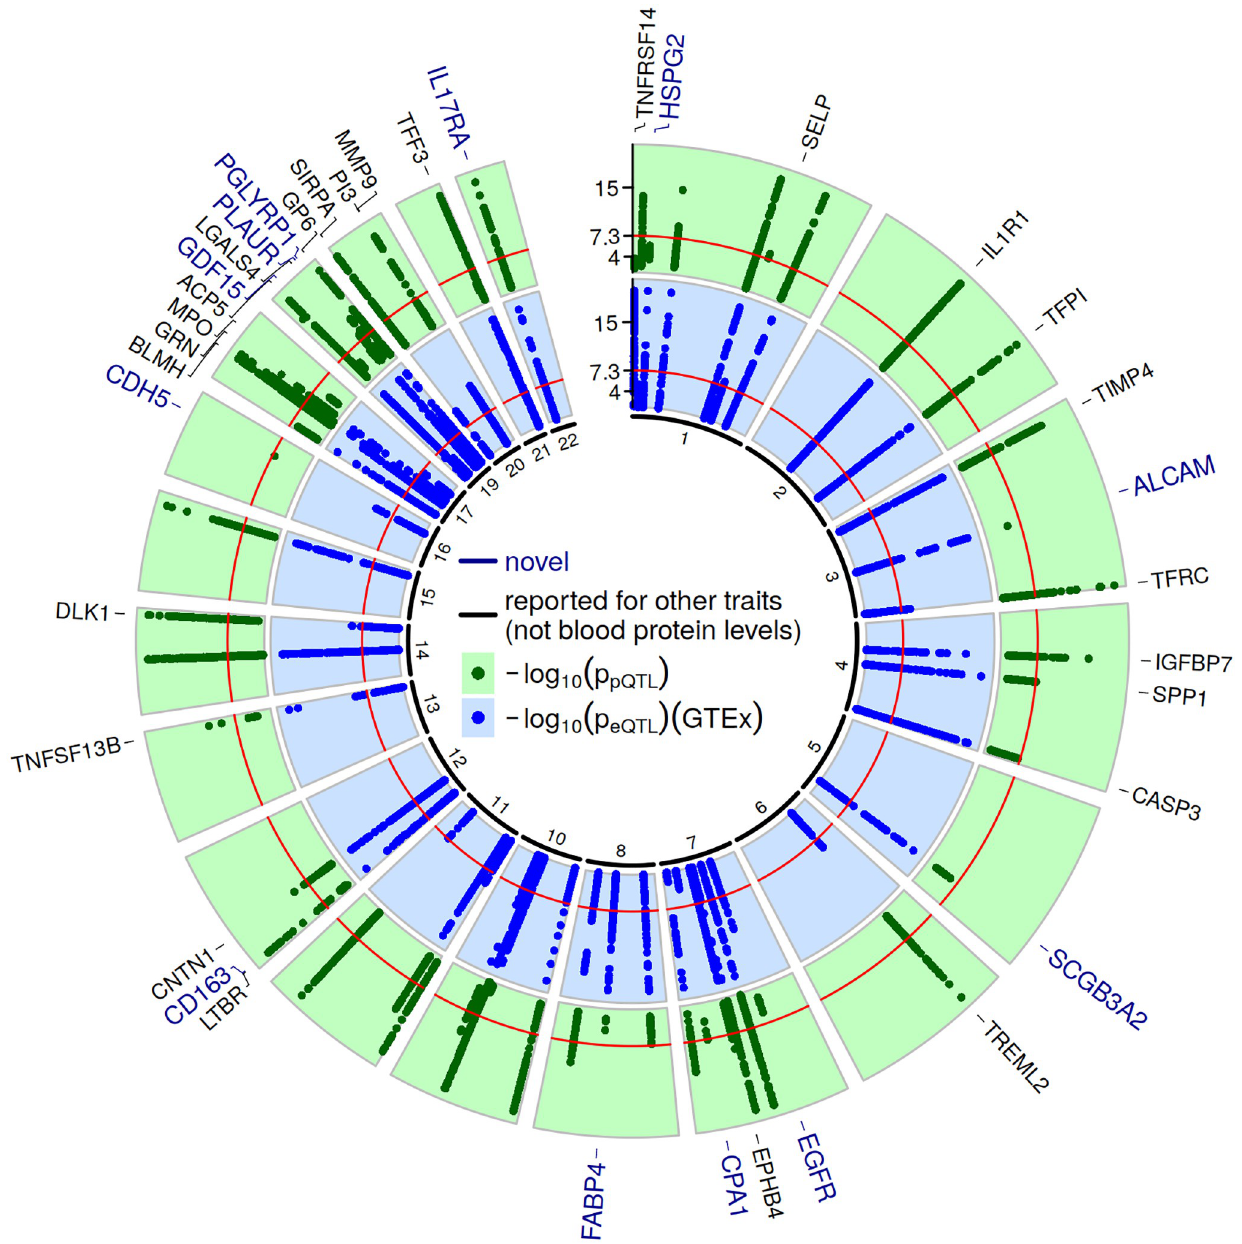
Fig 1. Circular plot of cis-associations. Log-transformed p-values for cis-pQTLs and eQTLs are shown in the green respectively blue circle. We obtained the statistics for eQTLs from GTEx and present the results of the tissue with the strongest eQTL per gene (see S3 Table in S2 File). For plotting, the y-axis was restricted to -log (p) = 20, i.e. all larger -log (p) values were set to 20. The red circles mark the classical genome-wide significance threshold (p = 5x10 -8 ). Gene names are added for loci not yet described for blood protein levels, and are colored with respect to the novelty level (blue: not described for any other traits, black: reported for other traits except for blood protein